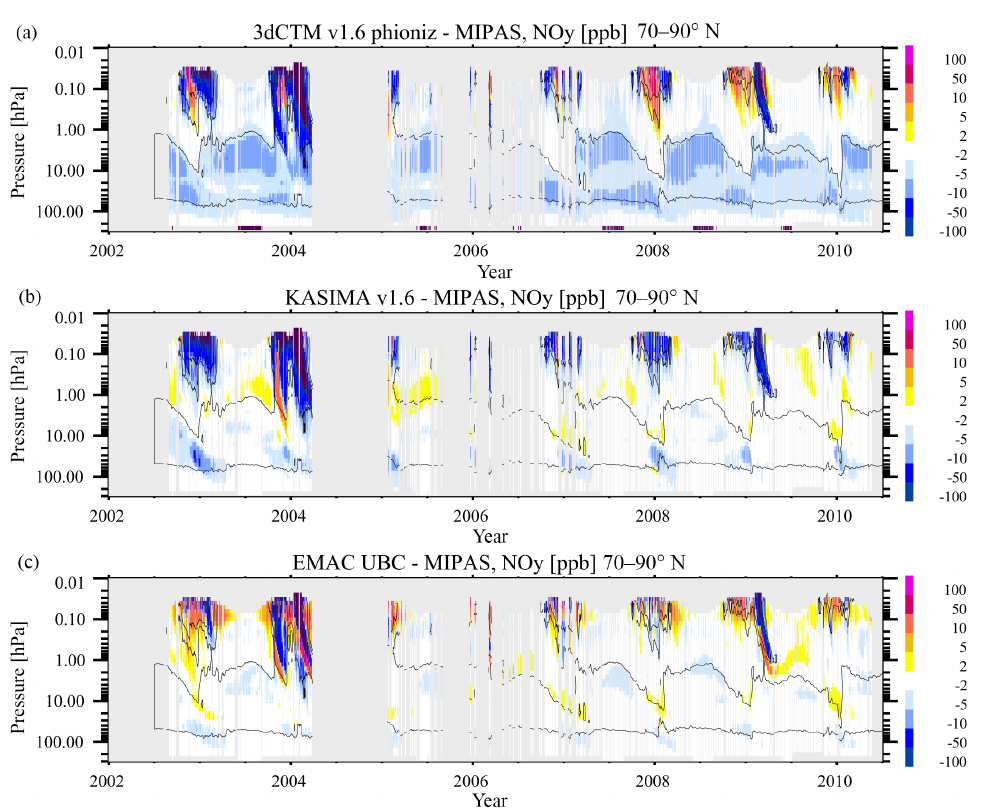
Figure 6. Absolute difference in NO y (ppb) between models and MIPAS observations at high northern (70–90 ◦ N) latitudes. Model data have been interpolated to the vertical grid of the MIPAS data, and only days and altitudes are shown where MIPAS data are available and fulfill the averaging kernel criterion. From top to bottom: 3dCTM v1.6 phioniz, KASIMA v1.6, and EMAC UBC. The black lines show the 10, 20, and 3000ppb contours of the MIPAS data, smoothed with a 7-day running mean for clarity. The gray shaded areas are periods without MIPAS data, and in the second panel the period before the start of the KASIMA model run is also